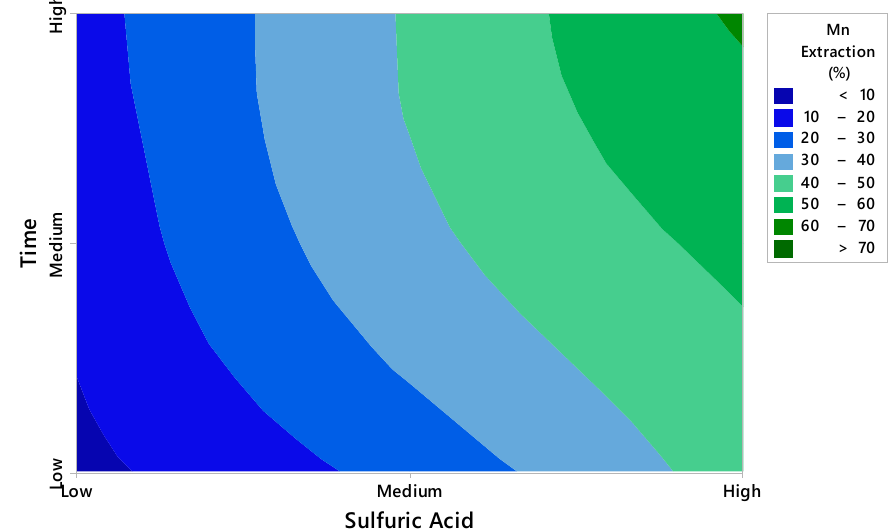
Figure 2. Experimental contour plot of Mn extraction (25 °C; 10, 20, 30 min leaching time; 0.1, 0.5, 1 mol/L H 2 SO 4 ).